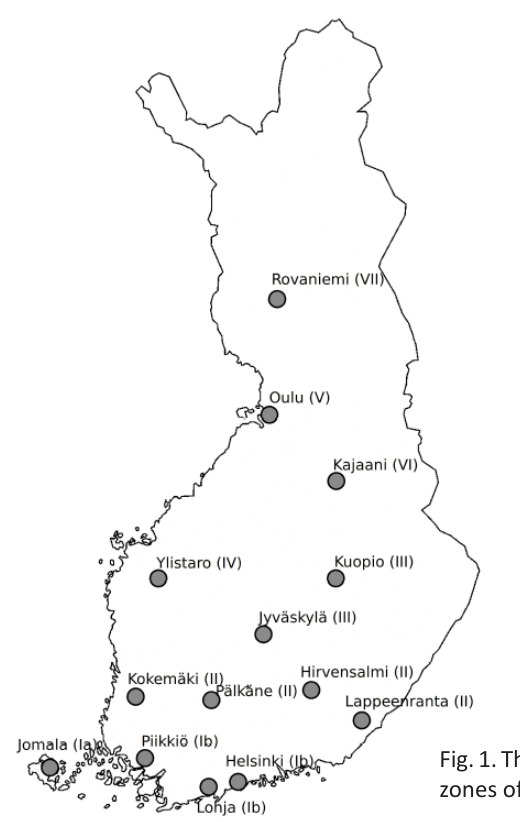
Fig. 1. The studied geographical locations. The plant growth zones of the locations are shown in